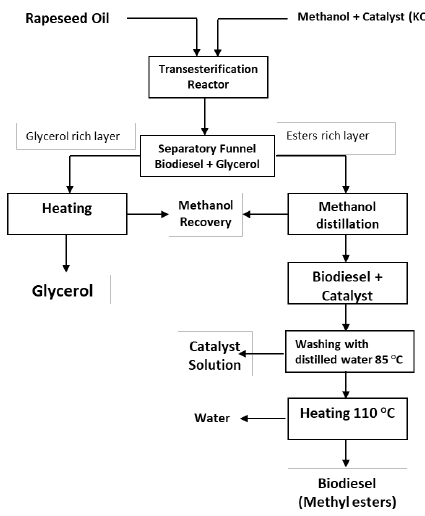
Figure 1. Schematic flow diagram of the biodiesel production from rapeseed oil.